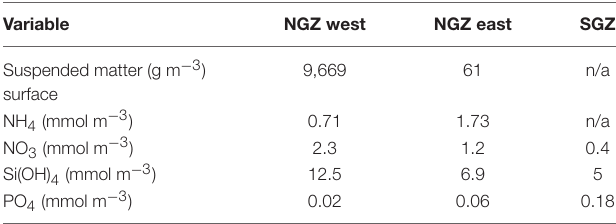
TABLE 2 | Nutrient and total suspended matter concentrations in terrestrial glacial meltwater rivers in the Northern Glacier Zone (NGZ) and in the Southern Glacier Zone (SGZ).